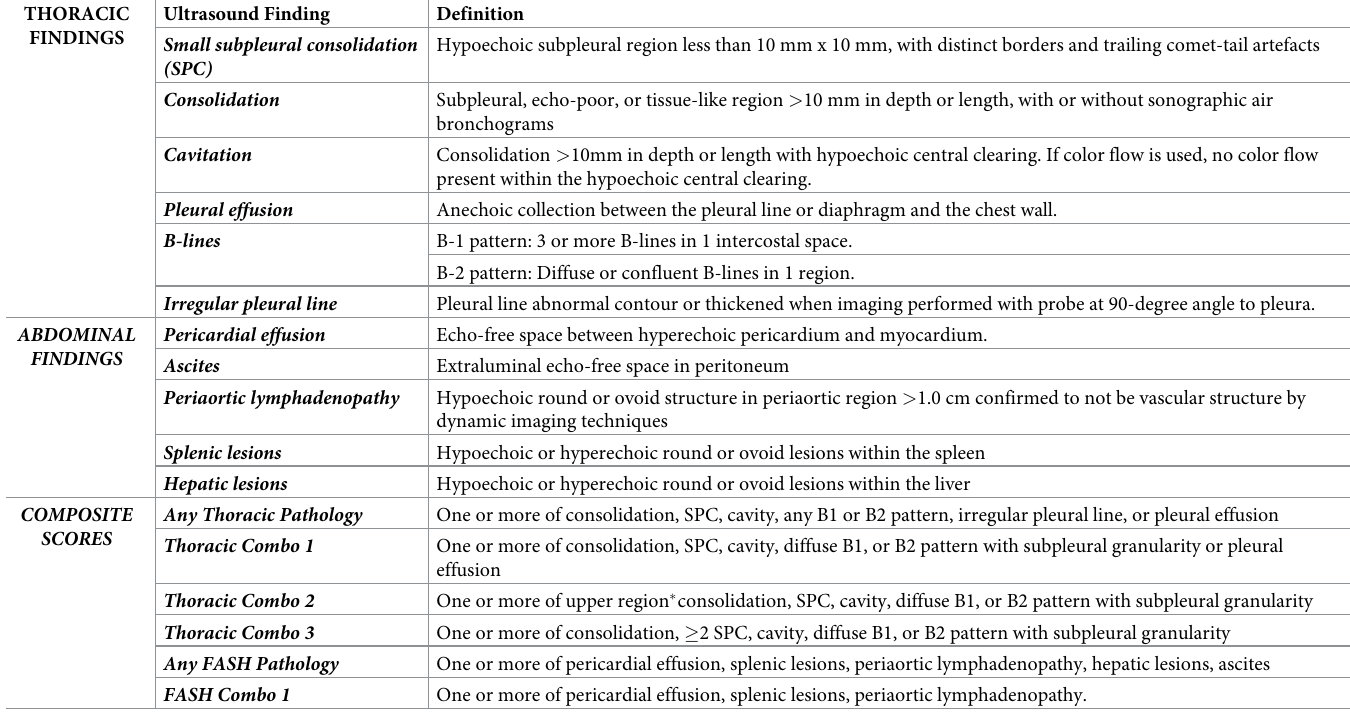
Table 1. Classification of ultrasound